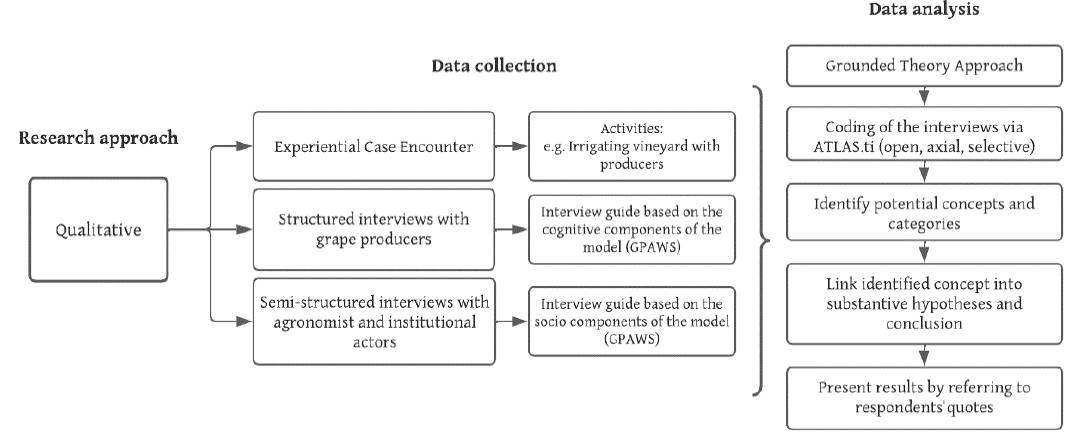
Figure 5. Overview of the research approach, data collection and analysis steps.